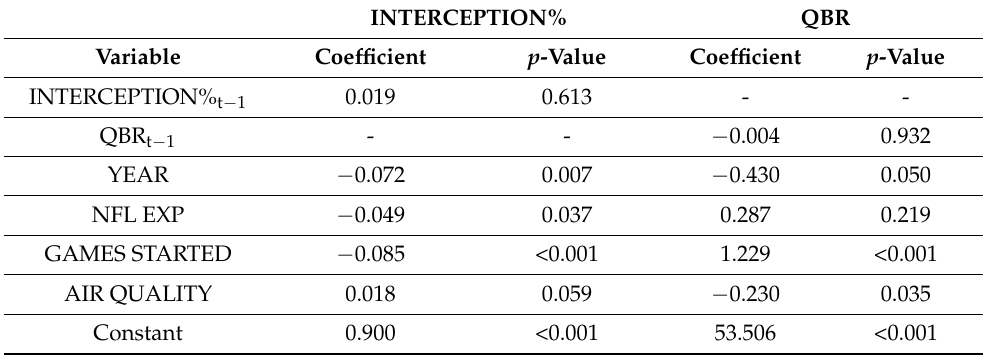
Table 6. Regression results of air quality as a predictor of interceptions and